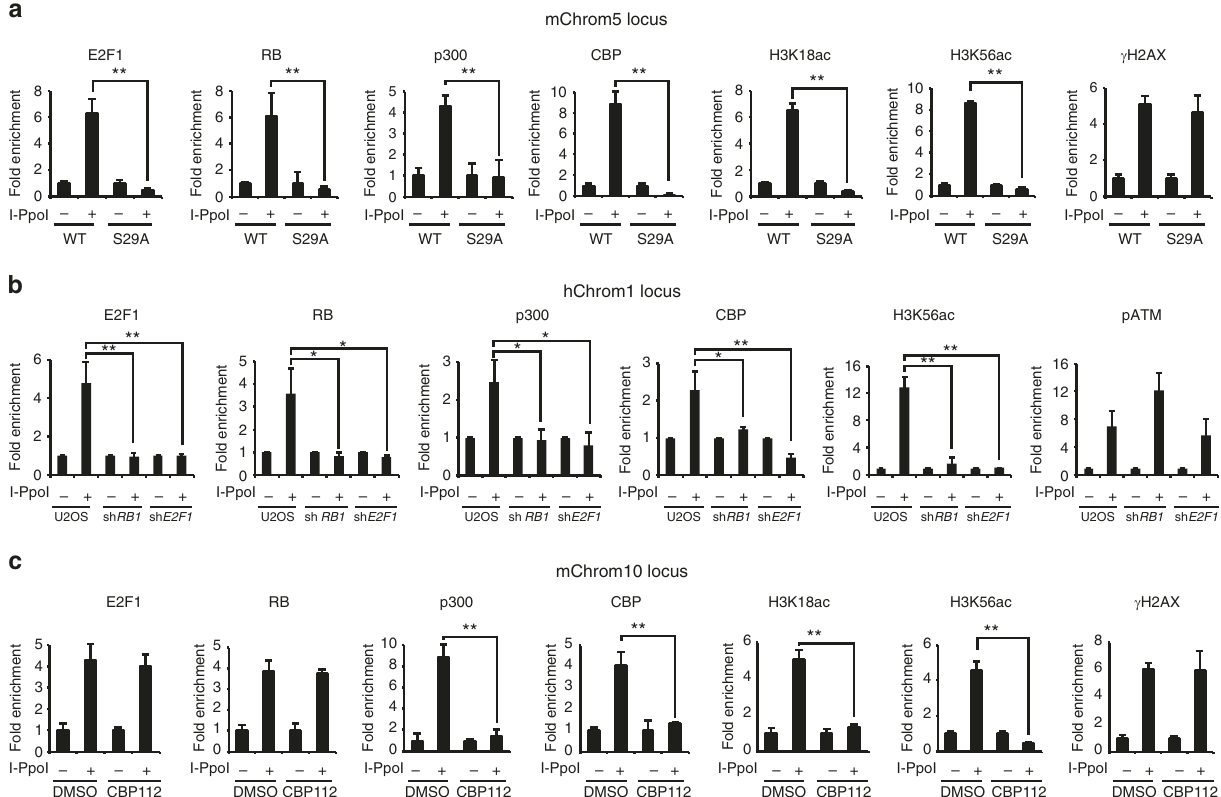
Fig. 3 Recruitment of p300 and CBP to DSBs is dependent on E2F1 and RB. a Primary wild-type (WT) or E2f1 S29A/S29A (S29A) MEFs were uninfected ( − ) or infected ( + ) with a retrovirus expressing HA-ER*-I-PpoI and induced with 2 μ M 4-hydroxy tamoxifen (4-OHT) for 12 h. ChIP was performed for E2F1, RB, p300, CBP, H3K18ac, H3K56ac, and γ H2AX as indicated. Occupancy was determined by qPCR for a region on mouse chromosome 5 (mChrom5), 166 bp 3 ’ to an I-PpoI cut site. Fold enrichment represents the ratio between percentage of input of infected cells and uninfected cells. b A similar I-PpoI ChIP assay was performed and analyzed as above using parental U2OS cells and U2OS cells expressing shRNA to RB1 and E2F1 . Occupancy of E2F1, RB, p300, CBP, H3K56ac, and phospho-ATM was determined for a region on human chromosome 1 (hChrom1), 280 bp 5 ’ to I-PpoI cut site. c Primary wild-type MEFs either untreated (DMSO vehicle) or treated with the bromodomain inhibitor CBP112 (1 μ M for 24 h) were subjected to the I-PpoI ChIP assay as above and occupancy was determined by qPCR at the mouse chromosome 10 (mChrom10) locus. Graphs represent average ± SD of three independent experiments ( n = 3). P values were calculated by unpaired Student ’ s t test. ** P ≤ 0.01 is highly signi fi cant and * P ≤ 0.05 is signi fi cant. Raw data of a – c are provided